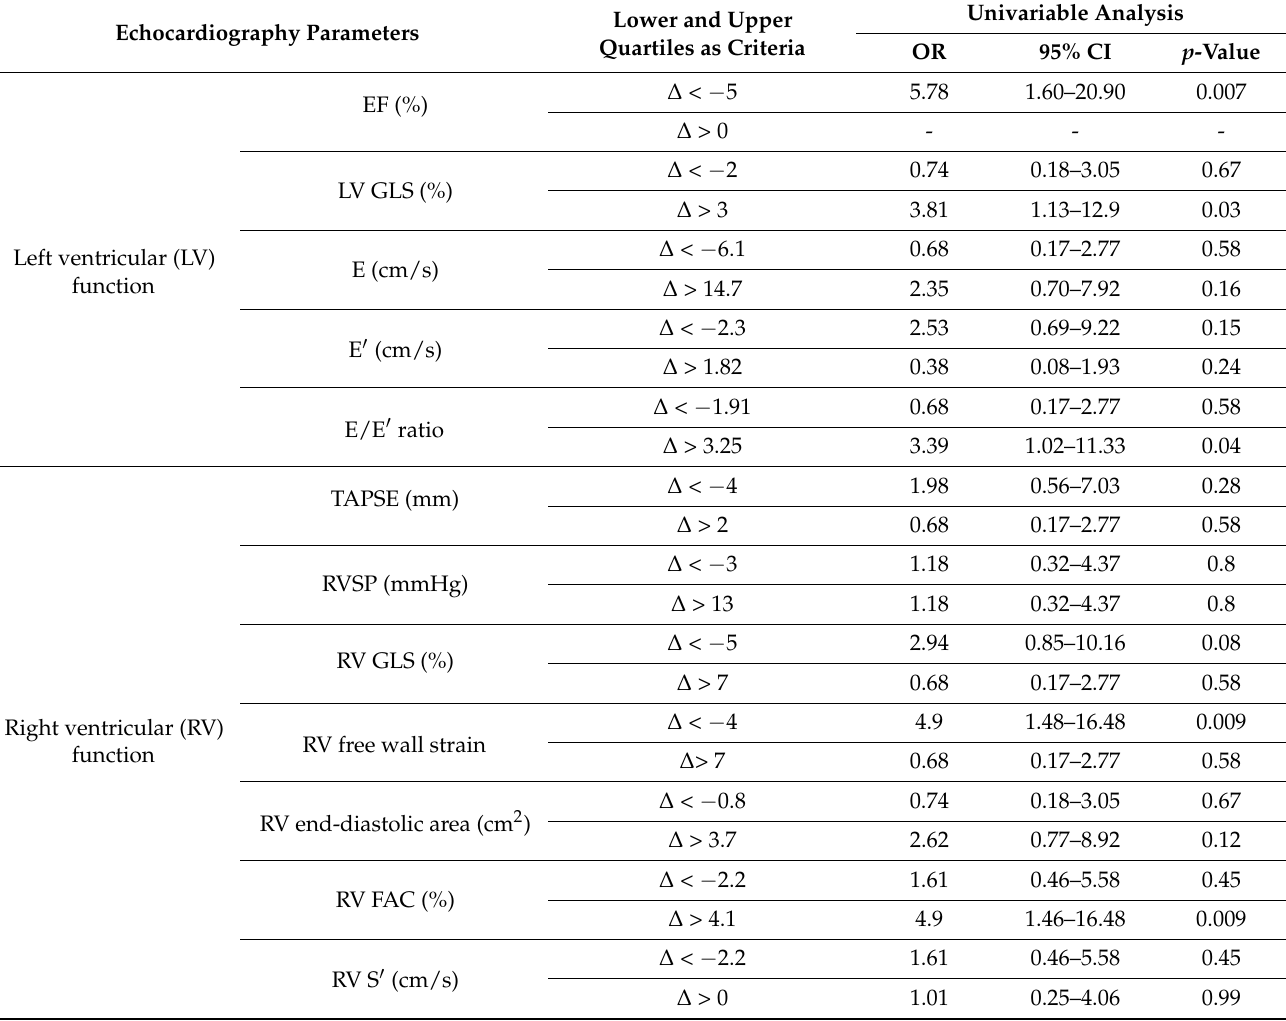
Table 3. Diagnosis of early progression in first CT evaluation in relation to changes of echocardiogra- phy parameters. Univariate logistic